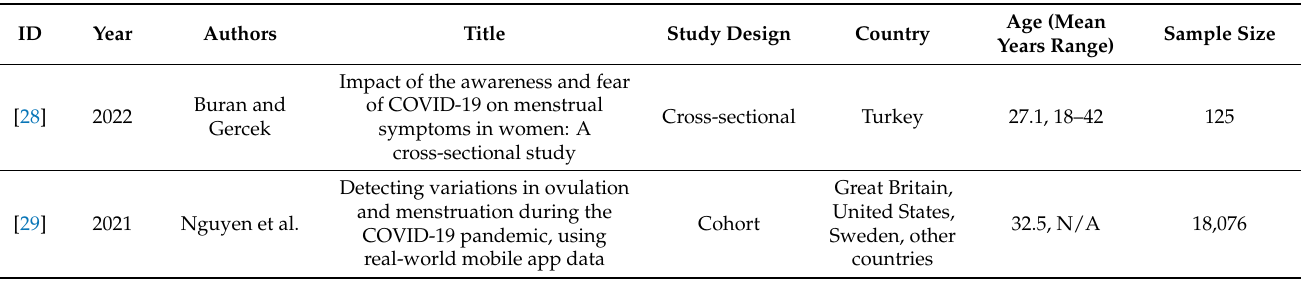
Table 1. Studies that report the characteristics of the menstrual cycle during the period of the COVID-19